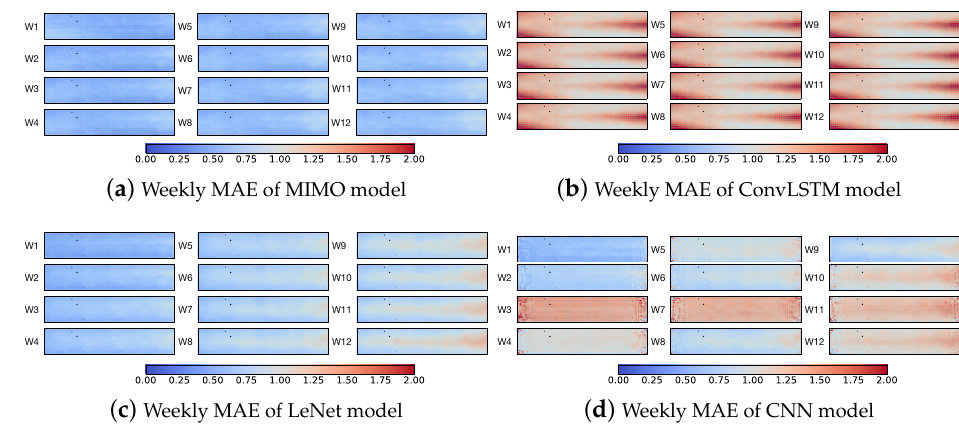
Figure 10. The results of weekly SST prediction in Ni ˜ no 3.4 region. In sum, in accordance with Figures 9–11, the MIMO model can achieve quite good prediction performance in all daily, weekly and monthly SST prediction. LeNet also achieves good prediction performance on daily SST prediction but has larger prediction errors than MIMO in weekly and monthly SST prediction. Both MIMO and LeNet largely outperform ConvLSTM and CNN.